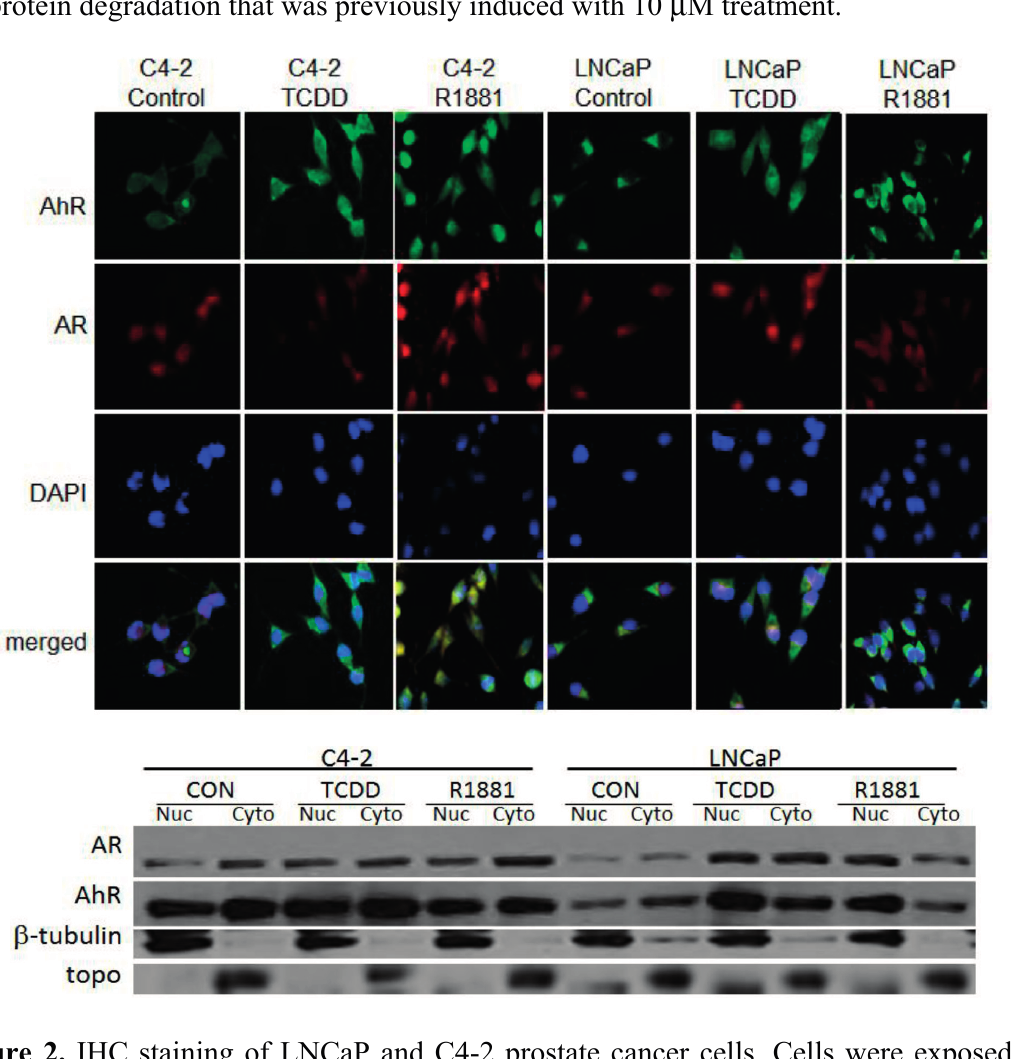
Figure 2. IHC staining of LNCaP and C4-2 prostate cancer cells. Cells were exposed to 1 μ M TCDD or 10 nM R1881 for 24 h. AhR was visualized by staining with FITC-conjugated goat anti-rabbit antibody and AR with Rhodamine-conjugated rabbit anti-mouse antibody. The nuclei were counter-stained with DAPI fluorescence dye. Images from